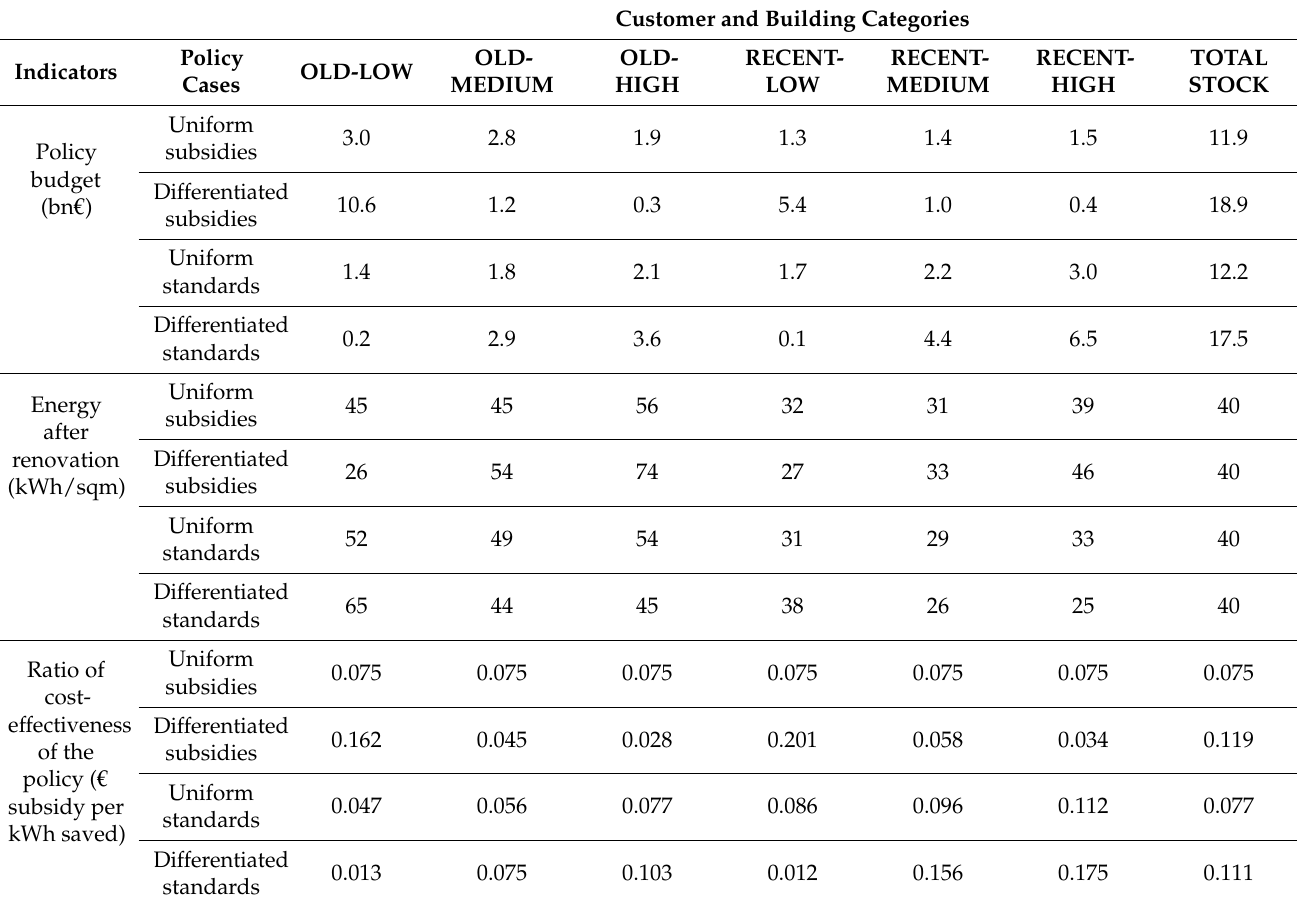
Table 7. Comparison of policy options from the perspective of cost-effectiveness of the